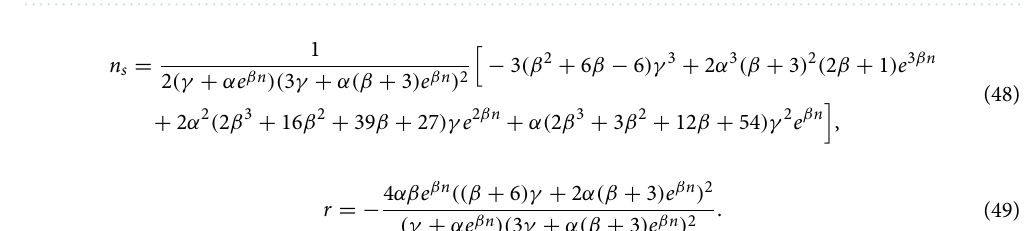
Figure 1. Behavior of the observational indices as a functions of parameter β for specific ratios ϒ = α/γ ( N = 60 ). Gray regions indicate compatibility of the n s and r with recent Planck and BICEP2/Keck array